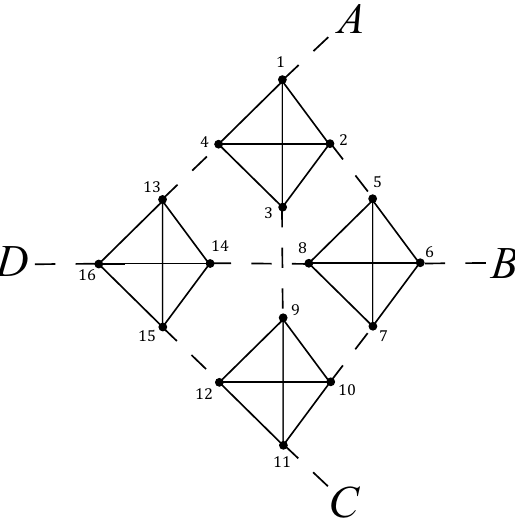
Figure 3. Sierpinski tetrix lattice at generation n = 2. Fictitious vertices A , B , C and D are introduced to accommodate the boundary